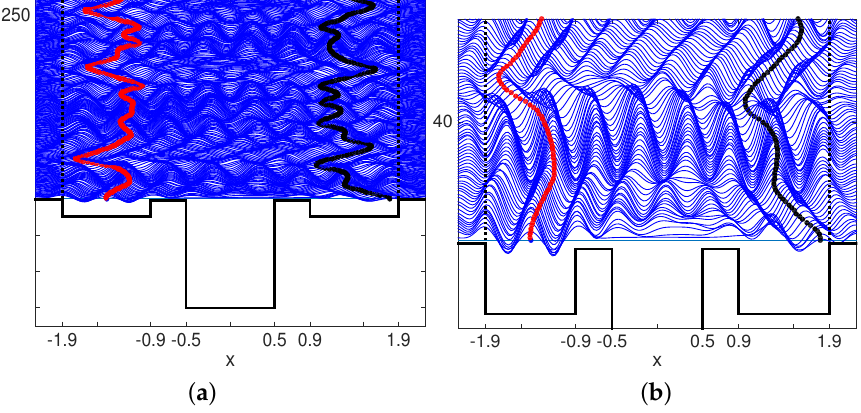
Figure 13. The data are similar to those of the simulation in Figure 12, but now the depth of the mid cavity has been increased to 3.0 cm, thereby enhancing communication between droplets. ( a ) On the left, we observe two droplets oscillating within their respective cavities. The pattern is different from that of Figure 12. The vertical axis indicates that the simulation goes a bit beyond 250 T F . The deeper mid-cavity acts as an amplifier for waves transmitted over barriers. This enhanced wave-mediated dynamics allow for a stronger interaction between the two droplets. The vertical droplet traces have more structure than before. ( b ) On the right graph we observe the detail of the wave field pattern. Just after time t = 40 T F we see how the sudden turn to the left of the right droplet causes the other droplet to also move to the left. This was not observed in Figure